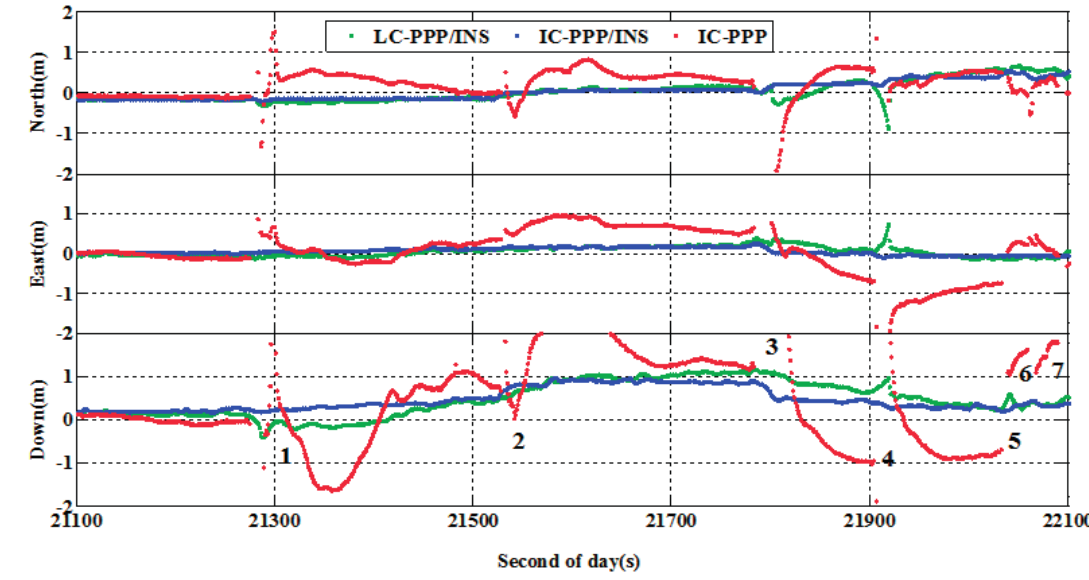
Figure 11. Position differences of IC-PPP ( red line), LC-PPP/INS ( green line) and IC-PPP/INS solution ( blue line) for the data with frequent GPS outages, on 7 January 2012 in Wuhan,